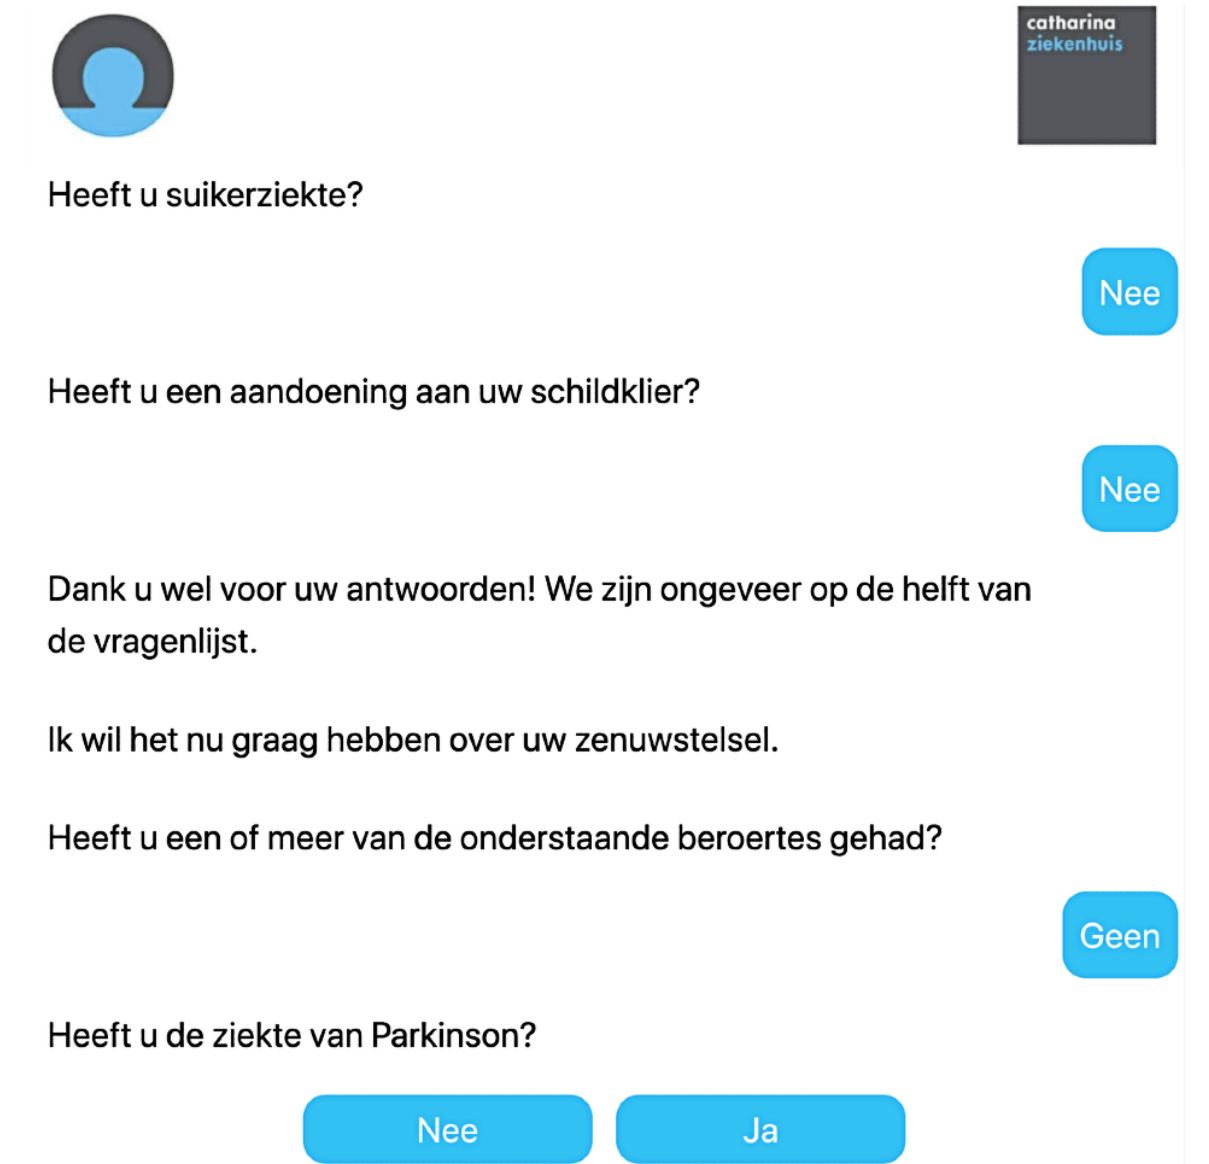
Figure 2. Chatbot